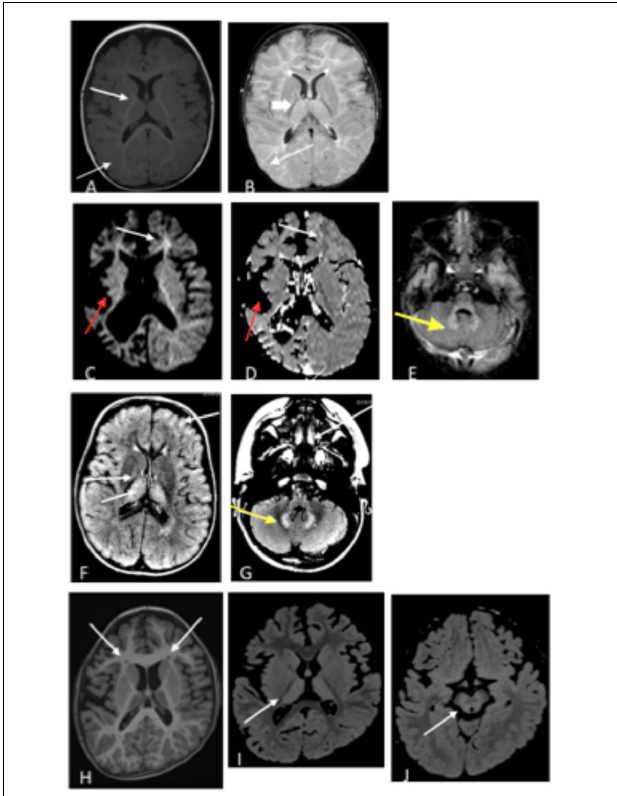
FIGURE 2 | (A,B) Patient 1 at 9 months old. (A) T1 axial image and (B) T2 axial image. No evidence of atrophy or injury. White arrows demarcate areas of delayed myelination; thick arrow show abnormal hyperintensity in bilateral thalamus. Images (C–E) . Patient 2 at 17 months old. (C) Axial diffusion weighted imaging (DWI) and (D) Axial apparent diffusion coefficient (ADC). Severe bilateral cerebral atrophy right side (red arrows) greater than the left side. Enlarged lateral ventricles secondary to ex vacuo loss. White arrows demonstrate acute restricted diffusion in white matter than can be related to acute injury. (E) Axial T2 FLAIR image with T2 hyperintensities indicated by yellow arrow in bilateral dentate nuclei. (F,G) Patient 3, age 3 years. T2 FLAIR axial images are shown. (F) White arrow shows T2 hyperintensities in bilateral thalami, and (G) Yellow arrow shows T2 hyperintensities in dentate nucleus. (H–J) Patient 4 at age 6 years. (H) Axial T1 image shows bilateral frontal periventricular heterotopia (white arrows). (I,J) Axial FLAIR images showed patchy hyperintensity in the thalamus (I) and midbrain (J) (white